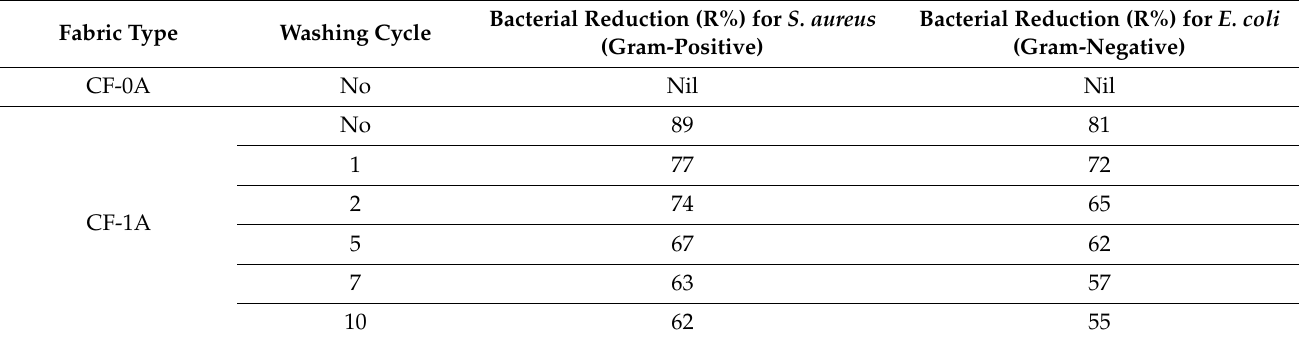
Table 9. Antimicrobial activity and wash durability of AgNP-deposited cotton fabric. Fabric Type